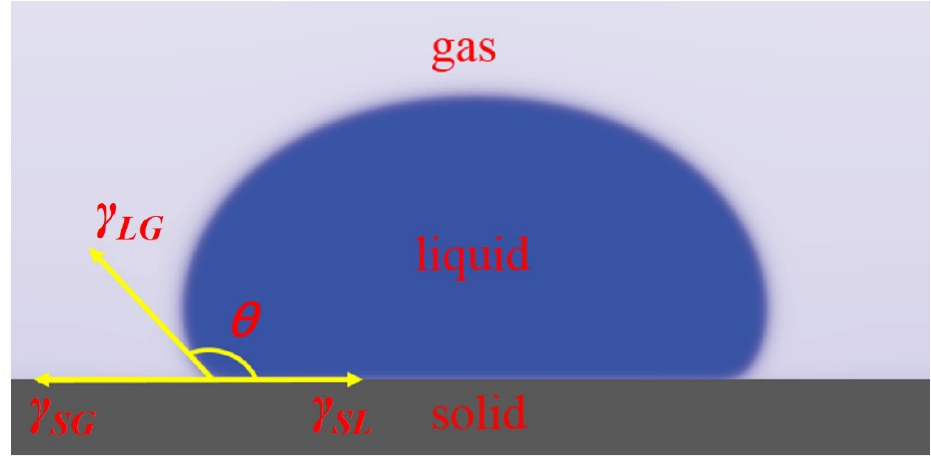
Figure 4. The contact angle of a liquid drop on the solid surface [26].